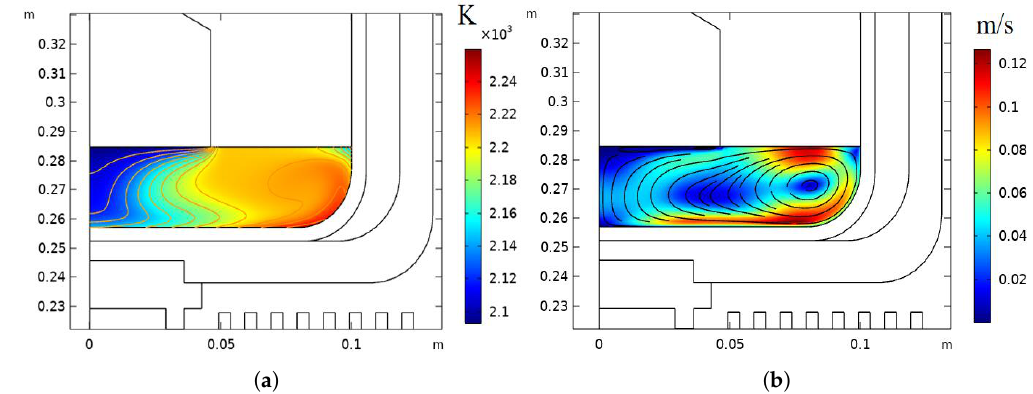
Figure 5. Crucible for four inches with rotation: ( a ) temperature distribution and isotherms; ( b ) streamlines of the velocity